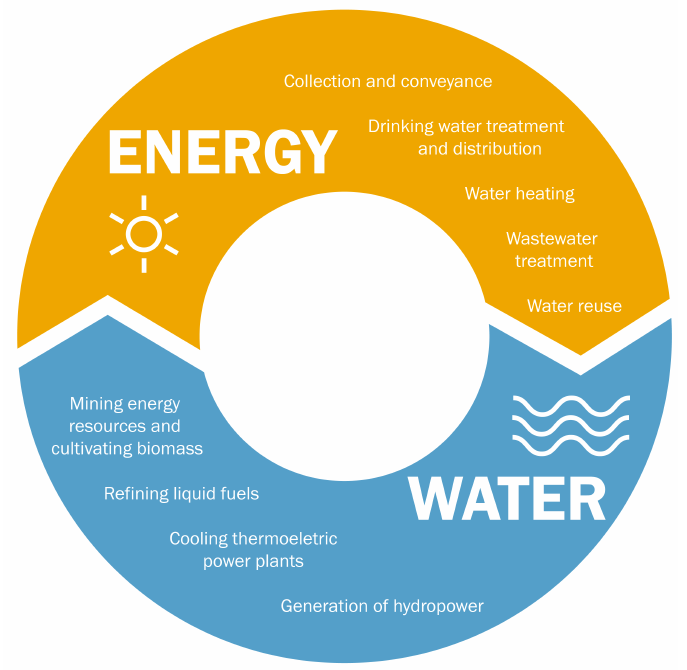
Figure 1. Key examples of interactions between water and energy systems. Adapted from Ref.